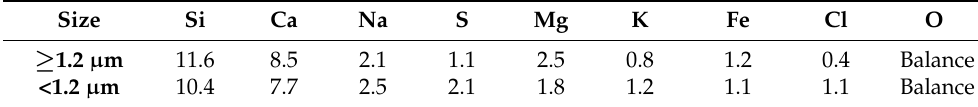
Table 2. Elemental constitute of dust particles (wt%). Increasing dust particle size causes a reduction in alkaline earth metal (Ca) and silicon (Si); however, alkaline metals (Na and K) and chlorine (Cl).